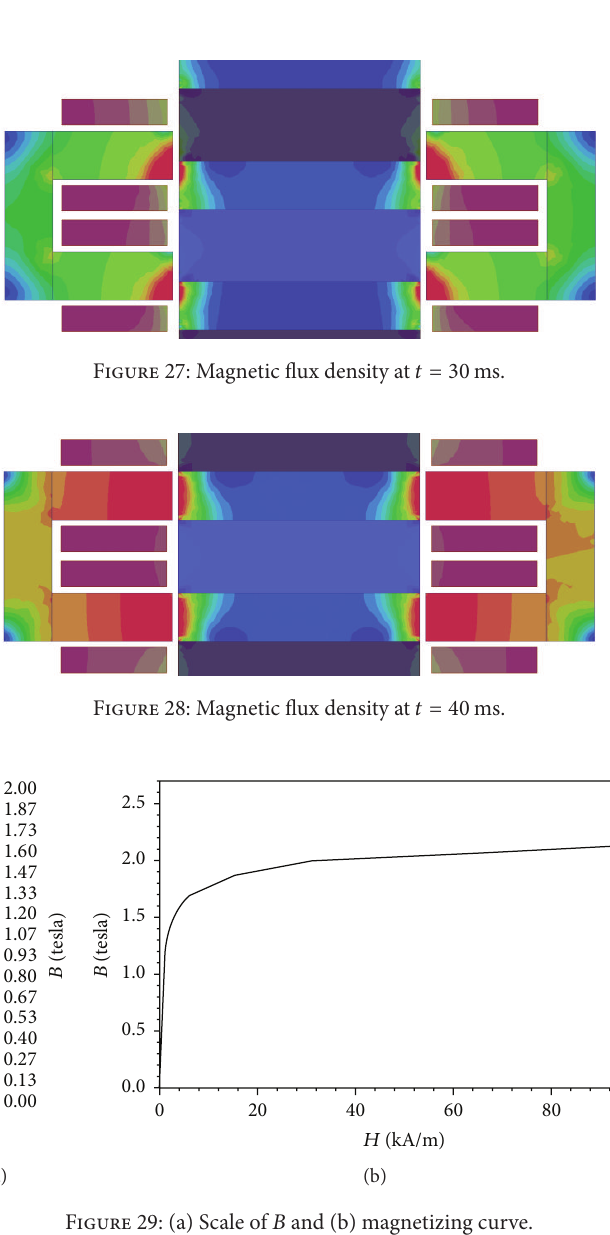
Figure 29: (a) Scale of 𝐵 and (b) magnetizing curve.